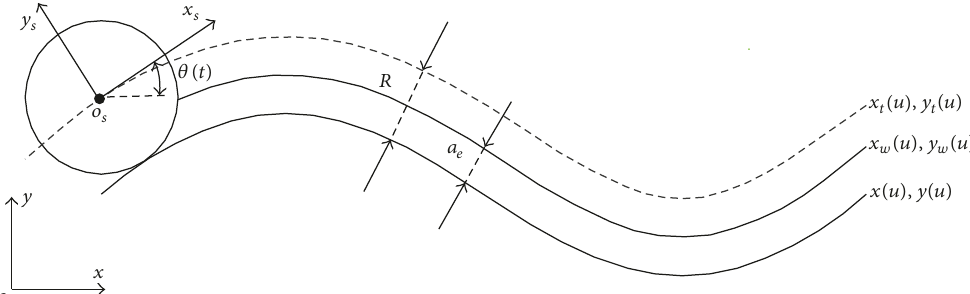
Figure 1: Schematic diagram of the proposed dynamic model describing the peripheral milling system for complex surface machining.